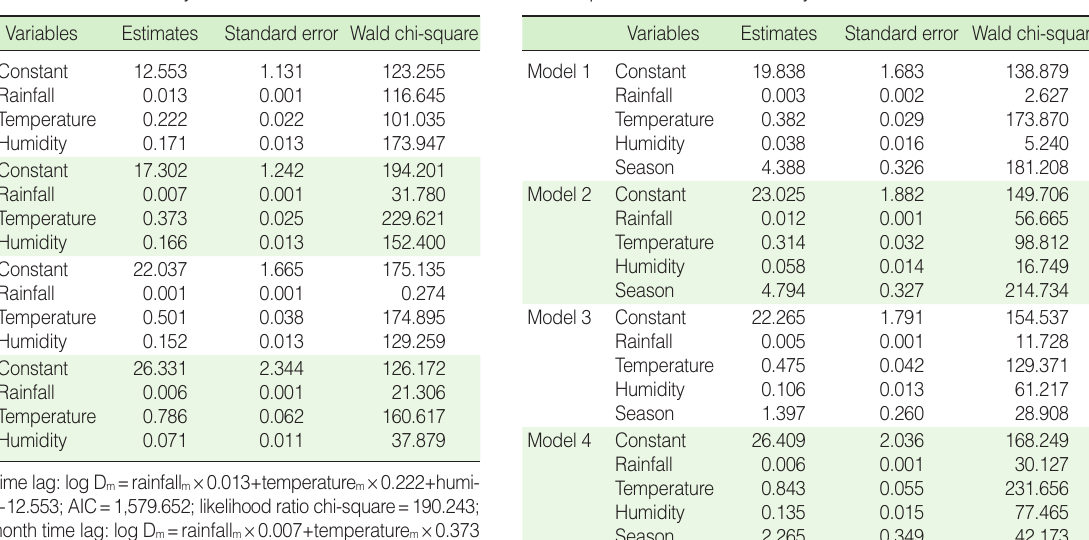
Table 3. Models based on a negative binomial generalized linear model relating the monthly number of dengue cases with rainfall, temperature, and relative humidity